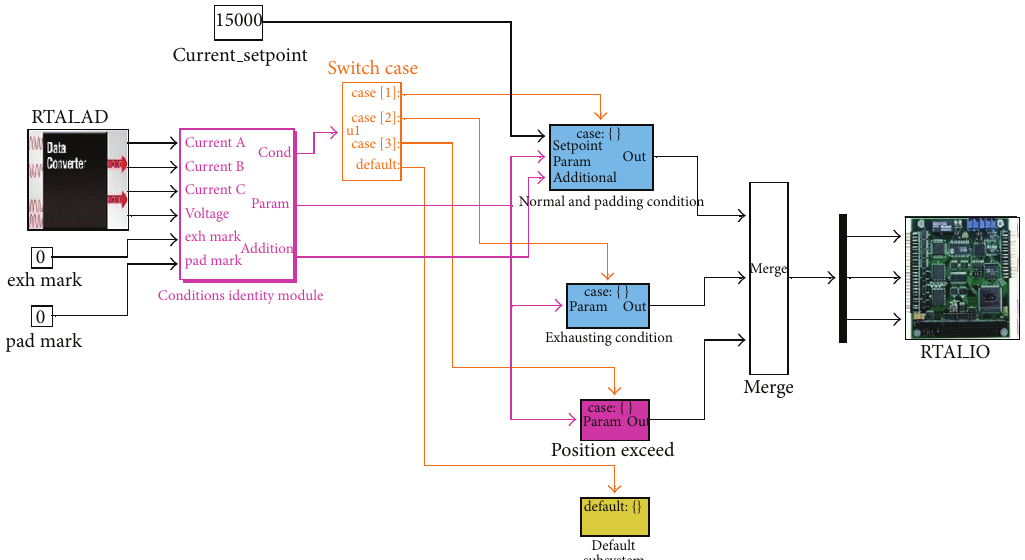
Figure 9: Simulink model of intelligent control strategy.